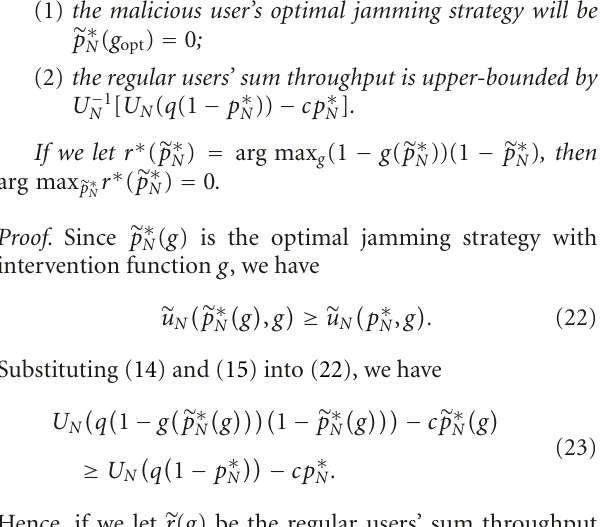
Figure 3: Sum throughput of the regular users without and with